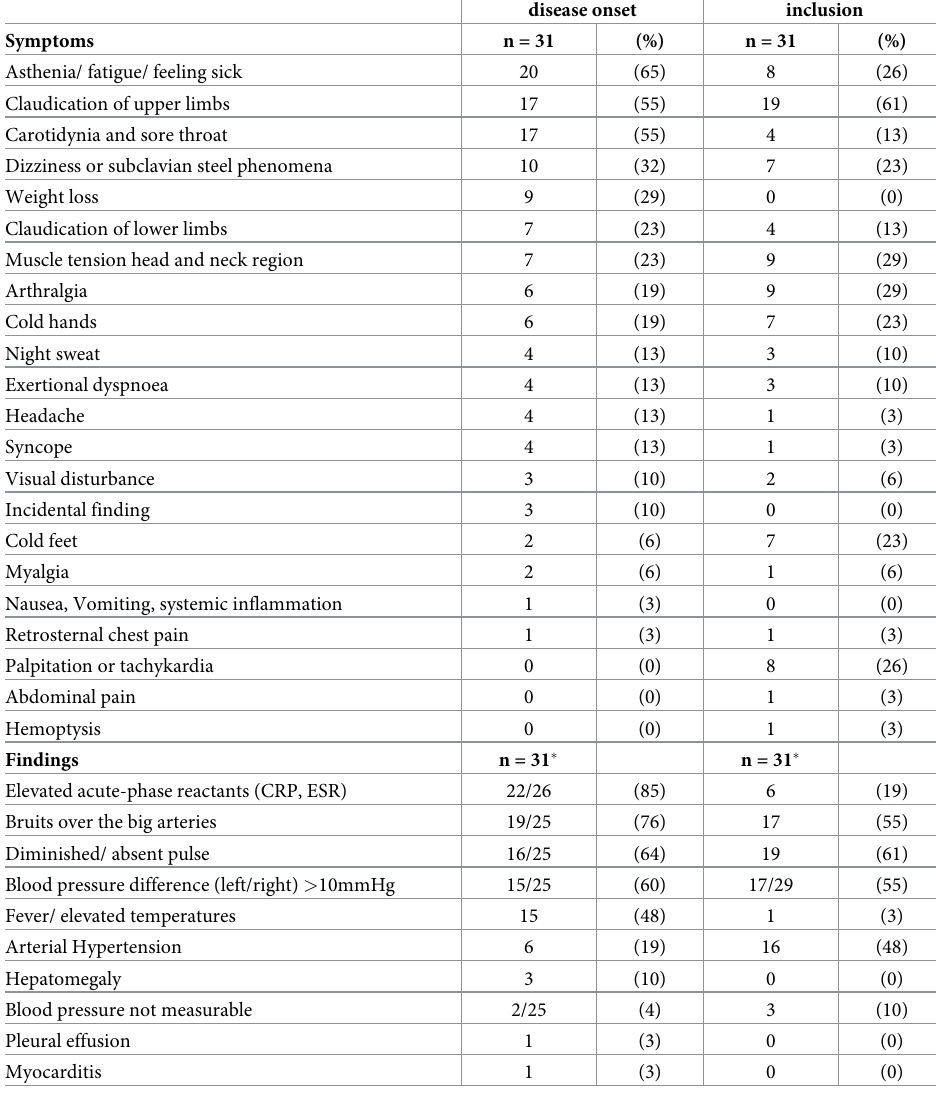
Table 3. Clinical features at disease onset and at inclusion.